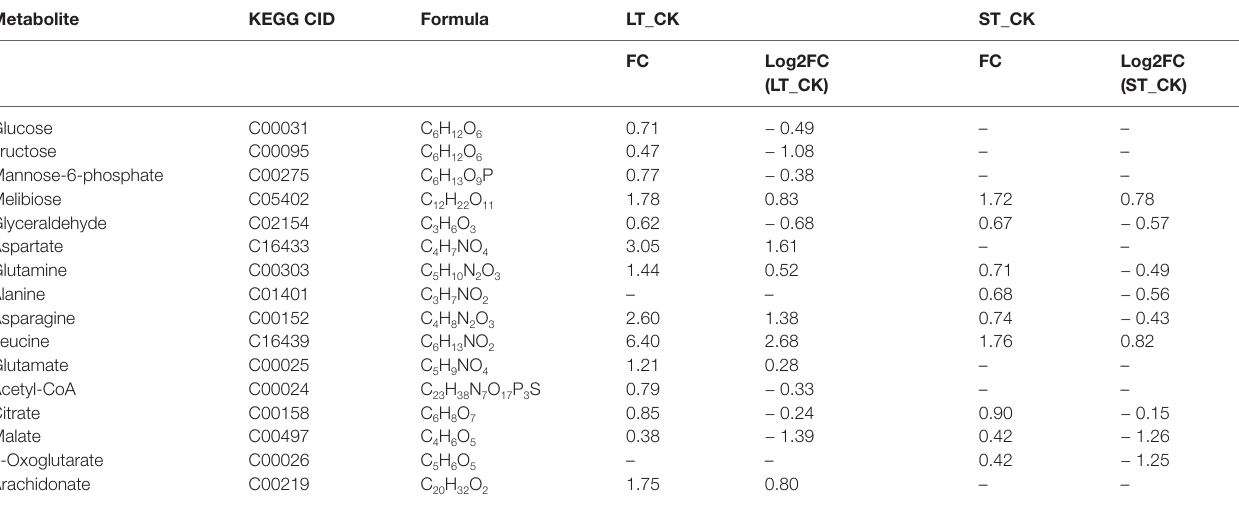
TABLE 5 | Significantly different metabolites related to C and N metabolism. Metabolite KEGG CID Formula